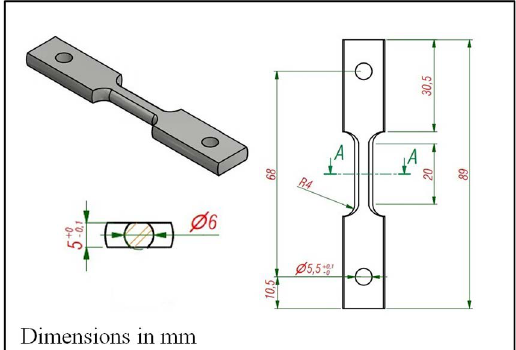
Figure 1. Shape and dimension (in mm) of the samples used for the XRD measurements.